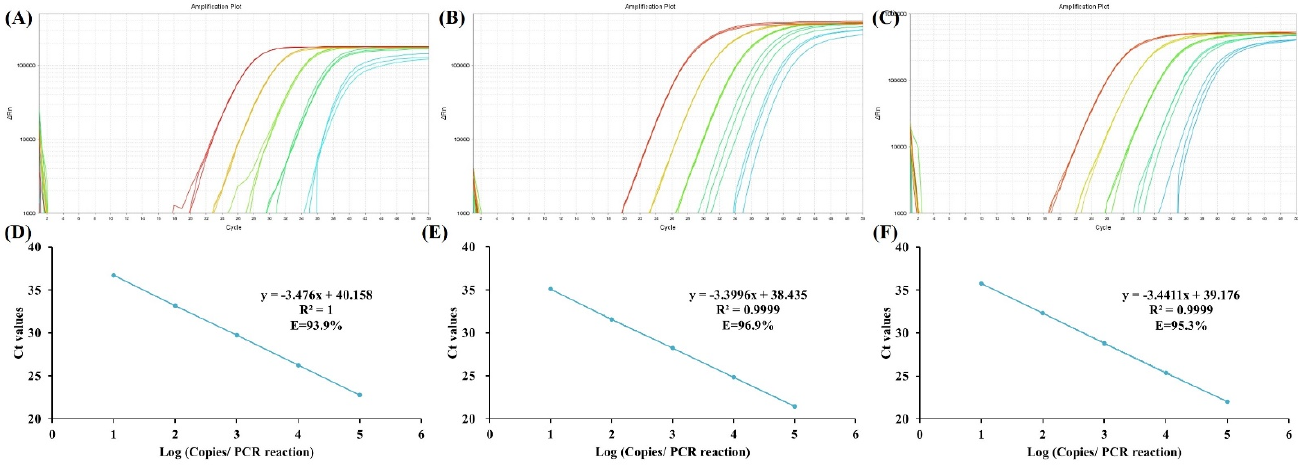
Figure 1. Amplification curve and PCR amplification efficiency by real-time qMSP of ELMO1 ( A , D ), ZNF582 ( B , E ) and TFPI2 ( C , F